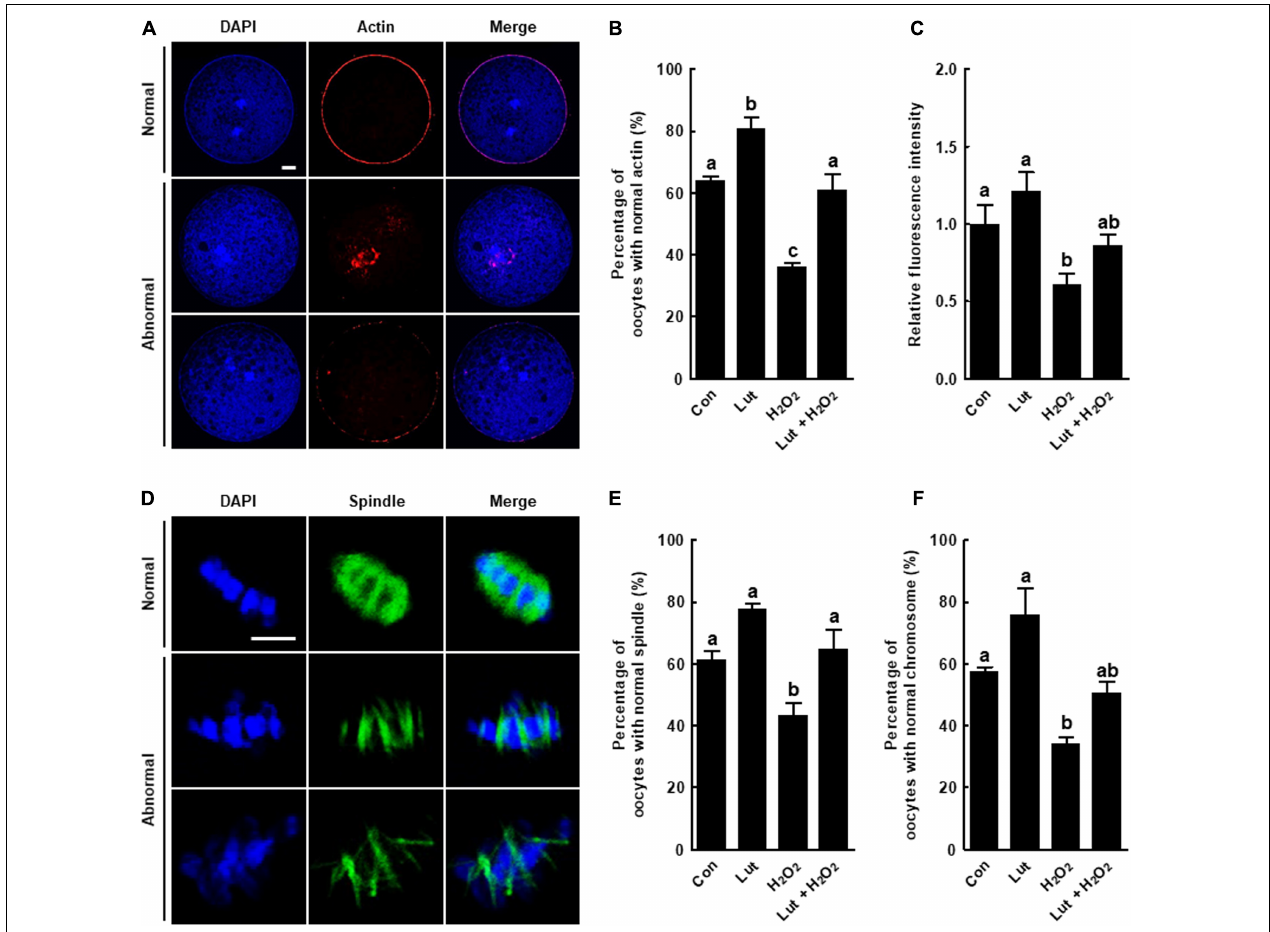
FIGURE 2 | Effects of Lut on actin and spindle defects induced by H 2 O 2 . (A) Representative images of normal and abnormal actin distribution in porcine oocytes. Scale bar = 50 µ m. (B) Percentages of oocytes with normal actin morphology and (C) relative intensities of actin signals in the indicated groups (Con, n = 25; Lut, n = 25; H 2 O 2 , n = 25; Lut + H 2 O 2 , n = 25). (D) Representative images of a normal and abnormal spindle and chromosome structures. Scale bar = 10 µ m. Percentages of oocytes with normal (E) spindle and (F) chromosome morphology in the indicated groups (Con, n = 32; Lut, n = 29; H 2 O 2 , n = 37; Lut + H 2 O 2 , n = 29). The data are from at least three independent experiments, and the different superscript letters represent the significant difference ( p <